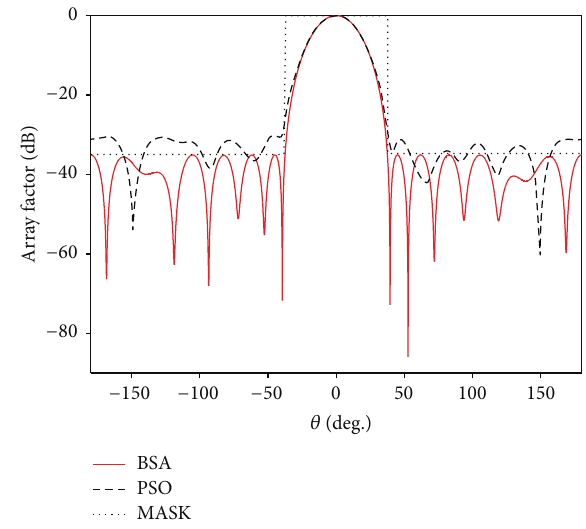
Figure 13: The radiation patterns obtained by BSA and EP [1] for CCAA with central element.